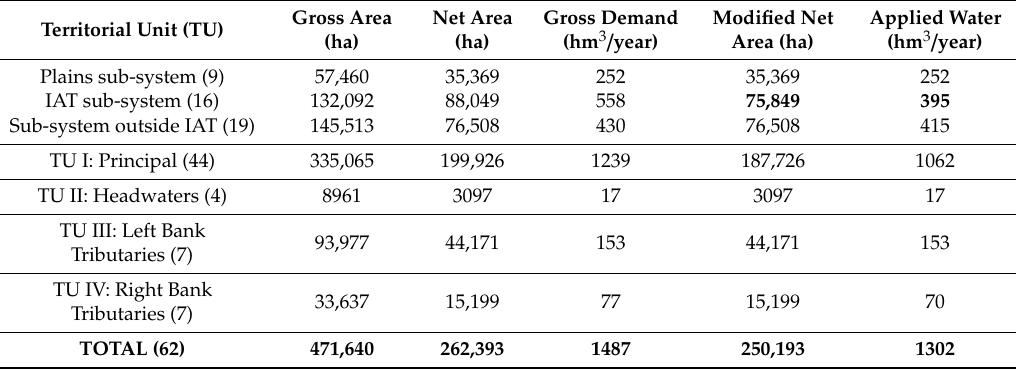
Table 3. Average applied water calculated in the SBHP 2015 / 21 (horizon 2015). Source: SBHP 2015 / 21. Own